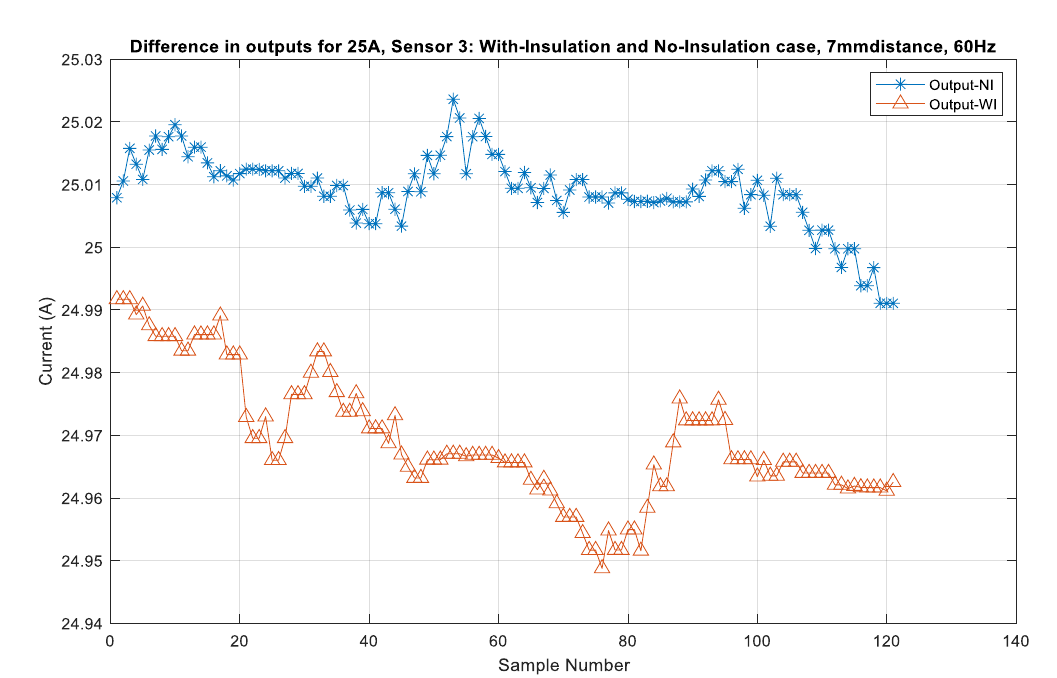
Figure 11. Sensor S3 output for 25 A: With-Insulation and No-Insulation case.